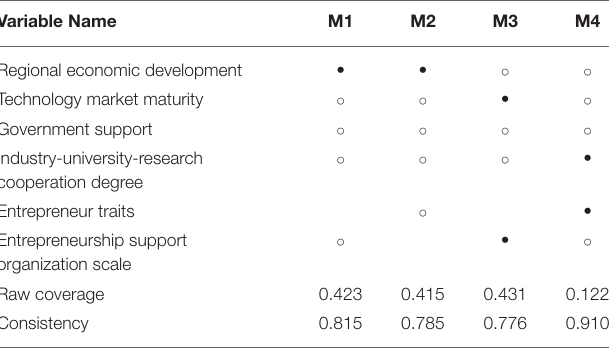
TABLE 1 | Combination analysis of sufficient conditions for efficient operation of an entrepreneurial ecosystem.